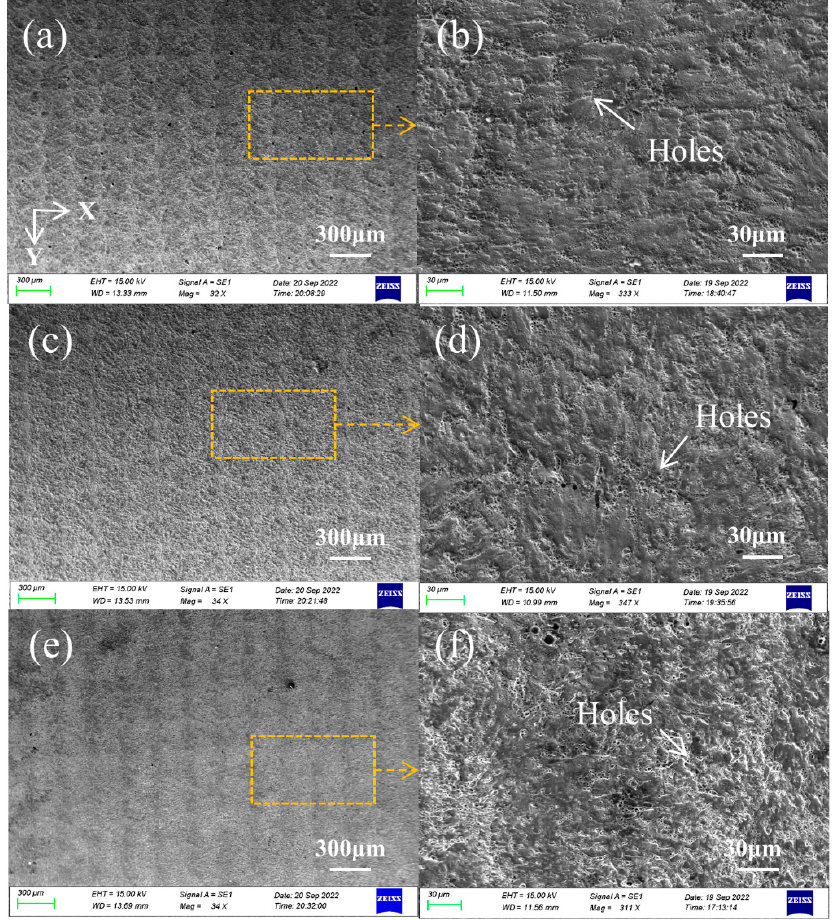
Figure 5. SEM morphologies after different energy treatments. ( a , b ) 50 mJ; ( c , d ) 150 mJ; ( e , f ) 200 mJ.